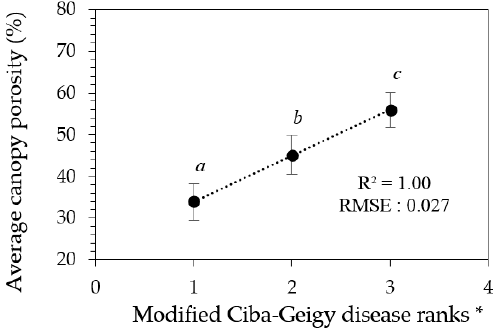
Figure 6. Graphical interpretation of confidence limits relating derived porosity values and the modified Ciba-Geigy disease ranks in Table 3. * Error bars indicate the confidence limits for each rank. Means with similar letters are not significantly different from each other at p < 0.05.